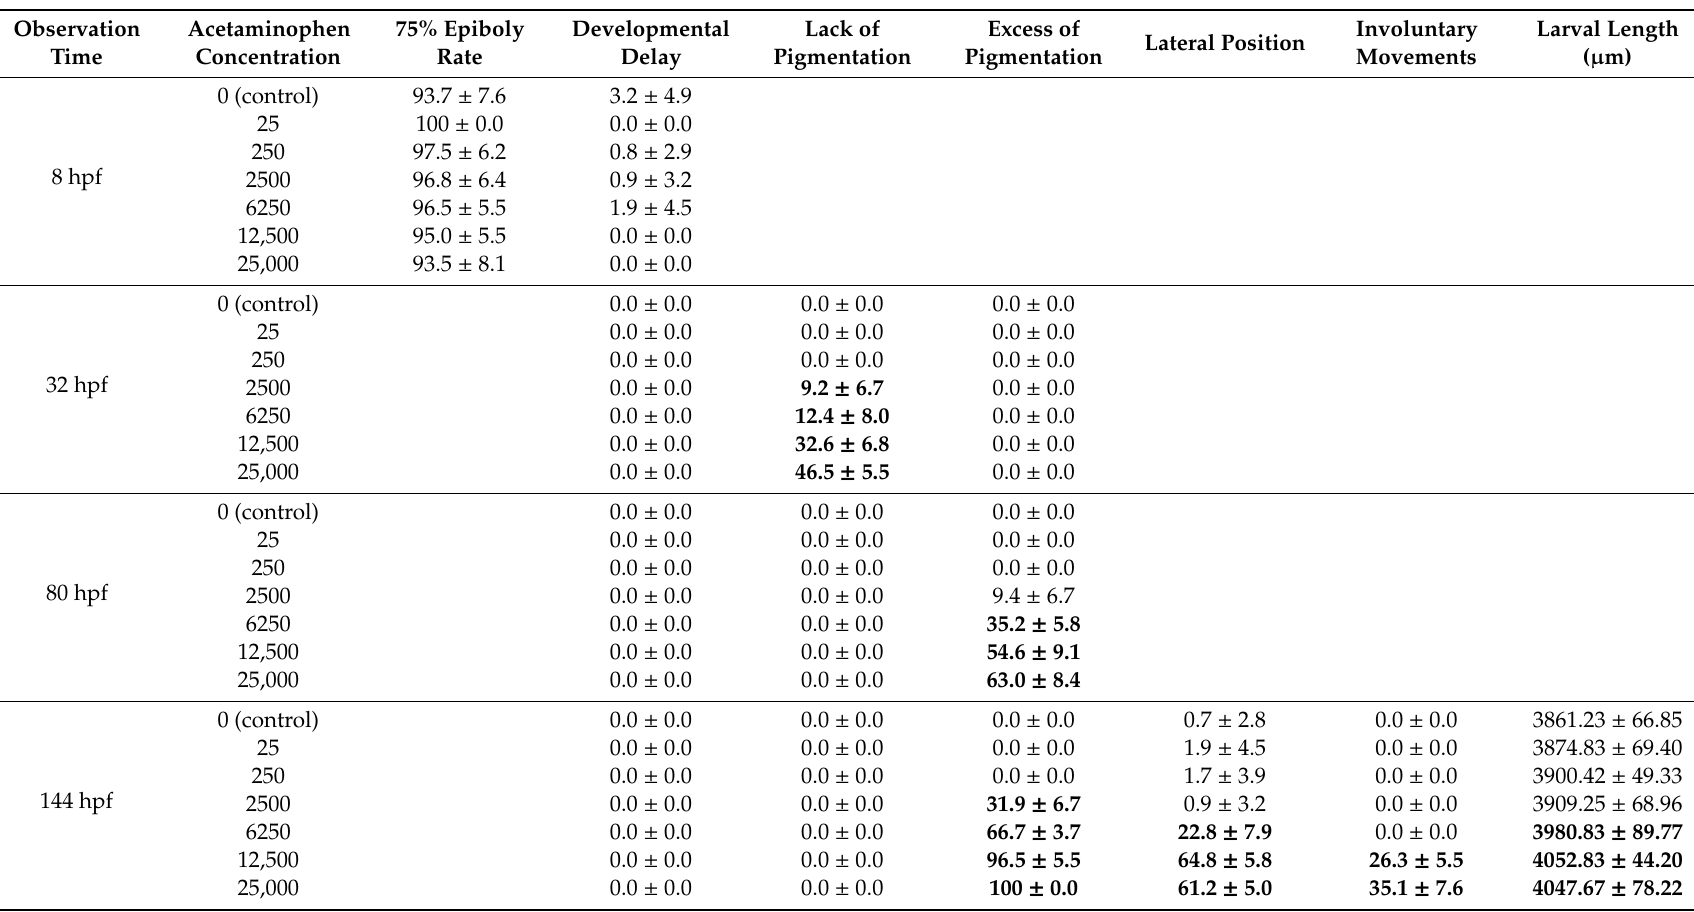
Table 1. E ff ects of acetaminophen experimental solutions with di ff erent concentrations on zebrafish embryos at the observation time-points considered in this work. Observation Acetaminophen Time Concentration